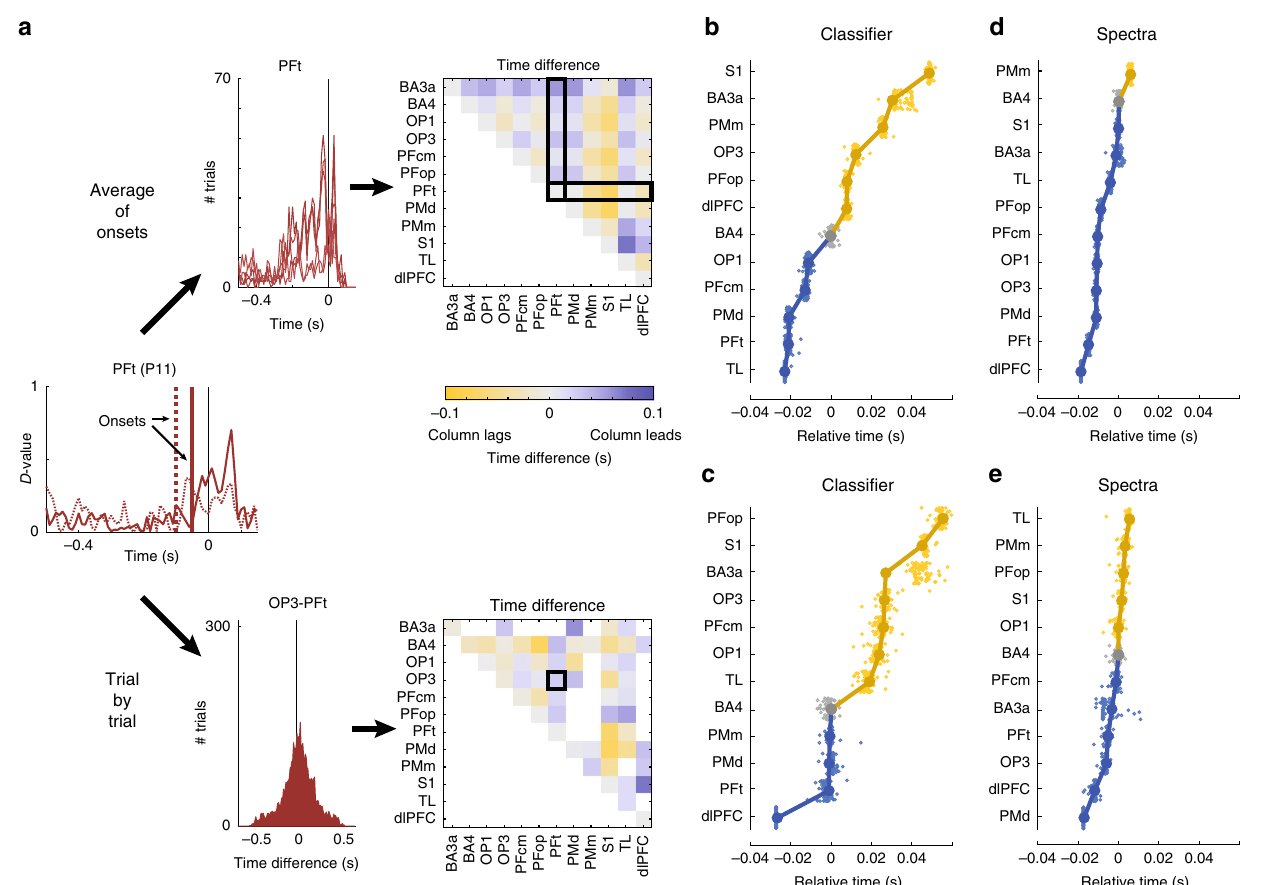
Fig. 4 Single-trial analysis of activity onset for classi fi er and spectral power traces. a Schematic explanation of single-trial onset analysis. For every single trial the onset of the highest peak of classi fi er performance ( D -values) or single-trial power trace was determined. Here, two example classi fi er D - value traces are shown for lead P11 located in area PFt, with onsets indicated by vertical lines. Subsequently, either the average onsets are computed across all leads in each area of interest, after which the differences of the average onsets is determined ( ‘ average of onsets ’ ), or the differences in onset of pairs of leads are compared for each trial, after which the differences are averaged within the areas of interest ( ‘ trial by trial ’ ). Both methods thus resulted in a difference matrix between all areas of interest, which was then ordered on a linear time axis using a multidimensional scaling approach. For power traces (not shown in this example), onset analyses were computed for each frequency independently and time difference distributions were combined across frequencies; b – e temporal ordering results of the average of onsets approach ( b , d ) and the trial-by-trial approach ( c , e ) for single-trial classi fi ers ( b , c ) and spectra ( d , e ). Connected fi lled circles indicate the onset of each area relative to the onset of area BA4 (gray), with blue areas starting before BA4 and yellow areas appearing after BA4. Small dots represent bootstrapping results, with each bootstrap leaving out the data from one recording lead ( N = 86). The classi fi er onset distributions of all leads can be found in Supplementary Fig. 12 and time difference matrices for all four methods are given in Supplementary Fig.